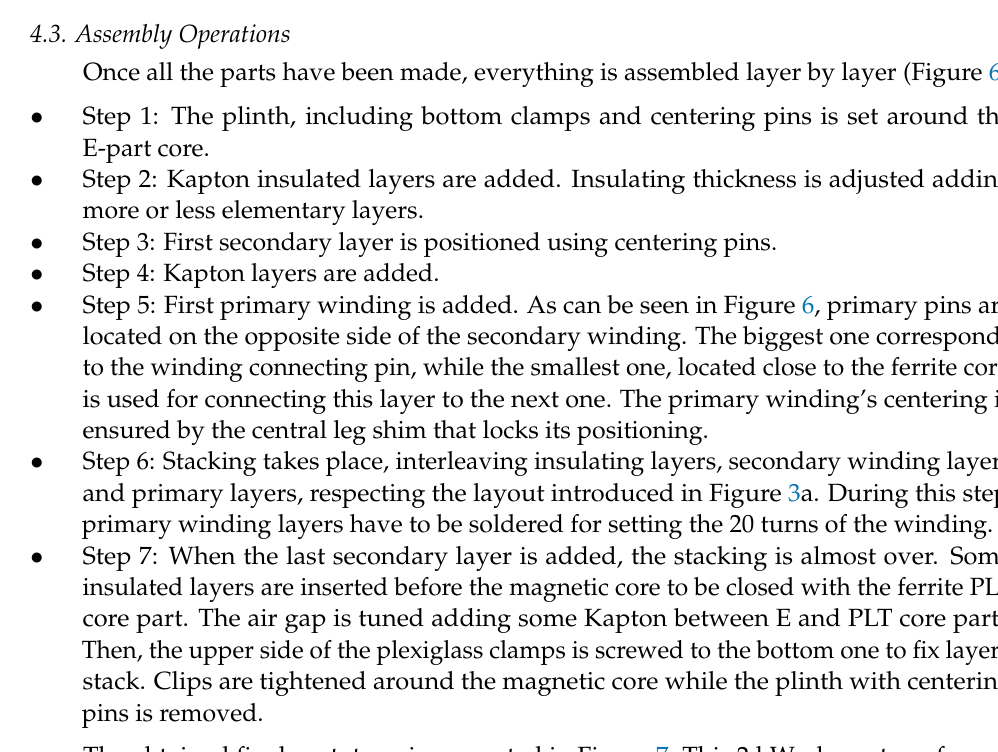
Figure 5. Milling